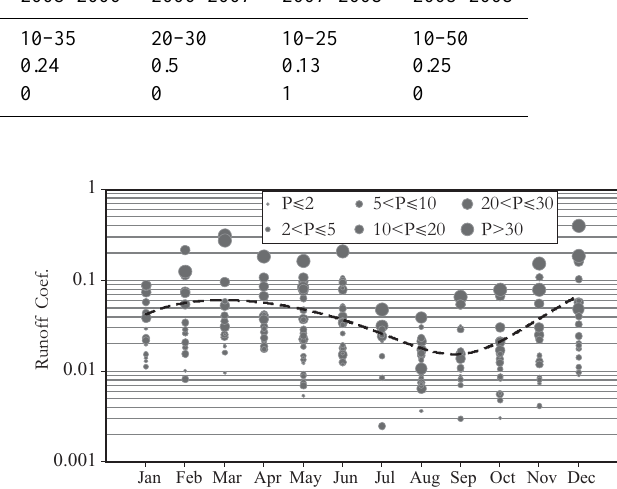
Fig. 5. Distribution along the year of runoff coefficients estimated for rainfall-runoff events observed between 2003 and 2008 in Aixola catchment. Size of the black dots represents total precipitation (mm) recorded during the